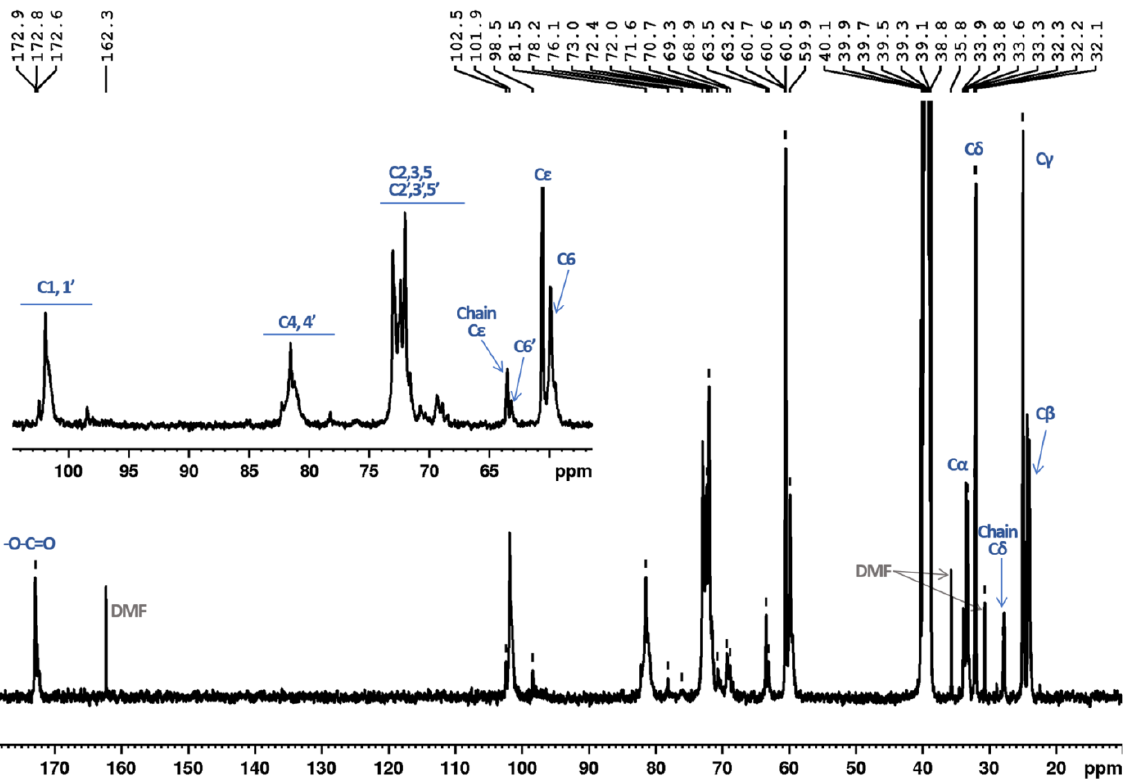
Figure 4. 13 C NMR (DMSO-d6, 400 MHz) spectrum of a typical CDCL product (synthesis #2) .